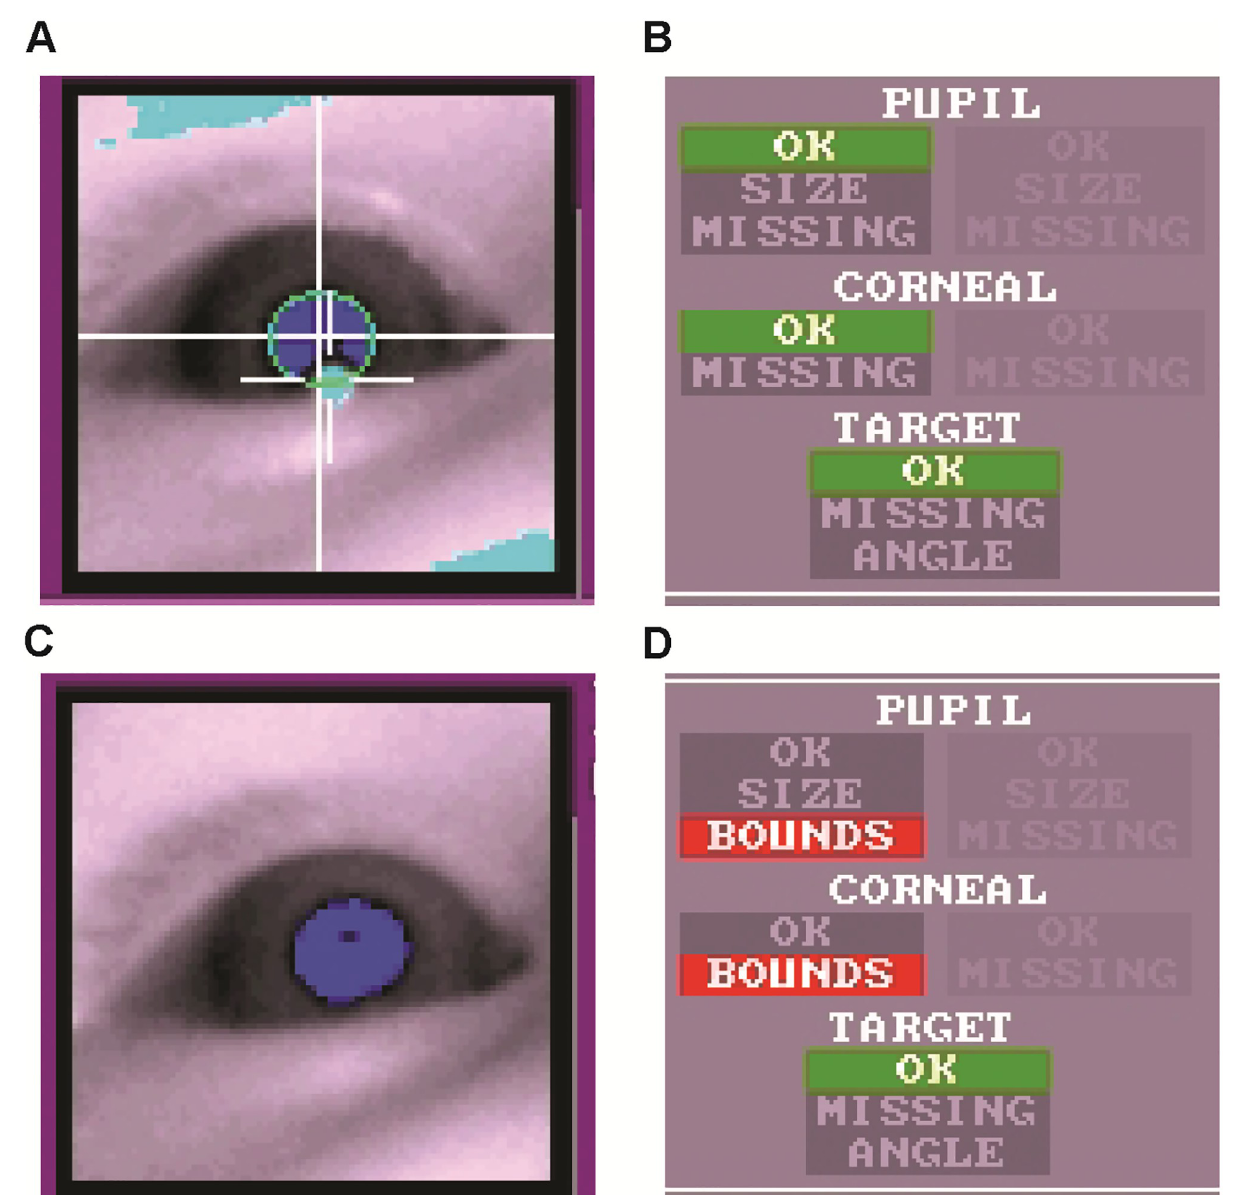
Fig 1. Example of loss of pupil and corneal reflections. A participant whose corneal and pupil reflection were initially successfully tracked (A,B), then subsequently obstructed by the lower eyelid (C,D). The Eyelink system tracks head distance relative to the camera using a small target sticker placed on the infant’s forehead. If the infant shifts position or turns away from the camera, tracking of the target sticker can be lost. The eye-tracker view of the participant’s eye image (A) demonstrates that pupil reflection (dark blue) and corneal reflection (cyan) were initially tracked by the camera. Status indicators (B) confirm that the camera was tracking the target sticker in addition to the pupil and corneal reflections. Relatively small head movements resulted in loss of pupil and corneal reflection due to obstruction by the lower eyelid (C). Status indicators (D) confirmed loss of pupil and corneal reflection, but no obstruction of the target sticker, verifying that loss of corneal reflection is not due to significant head movement or the infant looking away from the